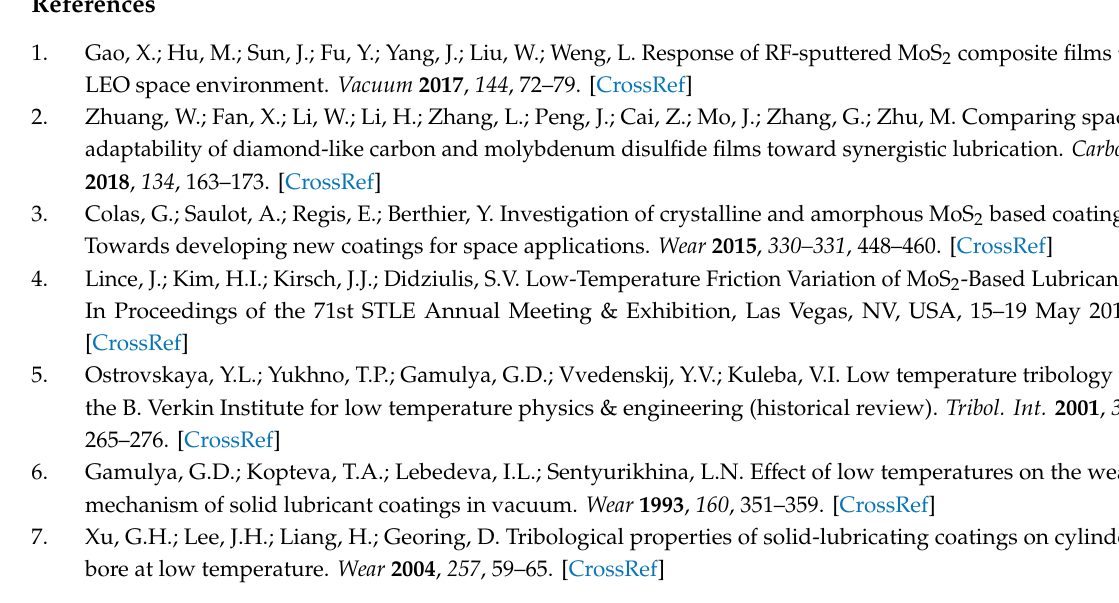
Figure S1: Possible local structures / atomic packings in amorphous MoS x coatings with x~2, 3, and 4 (Mo atoms—blue, S atoms—yellow). Di ff erent types of S ligands that may present in polymerized amorphous MoS x structures are indicated for Mo 3 S 12 and Mo 3 S 13 cluster unites in colored squares: green, terminal S2 2 − ; red, apical S 2 − ; blue, bridging S2 2 − ; yellow, unsaturated S 2 − , Figure S2: Anton Paar TRB3 tribometer modified by the authors for friction testing of MoS x thin-film coatings at low temperatures, Figure S3: Chemical mapping of S, Mo, Fe, and Cr over the surface of di ff erent samples obtained by RPLD of MoS x coatings on the polished steel substrates, Figure S4: RBS spectra for thin MoS x films obtained by RPLD on Si substrates at di ff erent pressures of H 2 S gas, Figure S5: Time-of-flight (TOF) signals of ion pulses detected by an ion probe during the pulsed laser ablation of a Mo target at di ff erent pressures of H 2 S gas, Figure S6: High resolution TEM and SAED patterns for thin MoS 4 film obtained by RPLD. The time of in situ electron beam irradiation of the film in the microscope was (a) 2 and (b) 10 min. The e-beam irradiation caused the local modification / crystallization of the film. Lattice spacing in the e-beam induced nanophase was ~0.26 nm. The nature of this nanophase has not been established. It can be assumed that the electron irradiation caused the desorption of sulfur atoms and, as a result, the local formation of the Mo 2 S 3 nanocrystals in the amorphous MoS x matrix. The high resolution TEM image of this compound clearly showed the lattice spacing of 0.255 nm [1], Figure S7: 2D images and profiles of the wear scar edge for the di ff erent MoS x coatings measured after tribo-testing at − 100 ◦ C in an oxidizing environment. Red lines show the cross sections of wear scars at indicated places; blue lines show the depths of the tracks alone the direction of ball sliding. For the MoS 2 coating, the profilometry studies revealed the uneven wear along the entire track, therefore, su ffi ciently accurate profiling along the track could not be done, Figure S8: Distribution of elements (Mo, S, Fe, Cr, and O) across the central part of the wear track on the MoS 2 coating after tribo-testing at − 100 ◦ C in an oxidizing environment, Figure S9: Distribution of elements (Mo, S, Fe, Cr, and O) across the central part of the wear track on the MoS 3 coating after tribo-testing at − 100 ◦ C in an oxidizing environment, Figure S10: Distribution of elements (Mo, S, Fe, Cr, and O) across the central part of the wear track on the MoS 4 coating after tribo-testing at − 100 ◦ C in an oxidizing environment, Figure S11: Friction curves of tests conducted at 22 ◦ C for di ff erent RPLD MoS x coatings in an argon-air mixture (RH~9%), Figure S12: Optical images of the wear tracks for di ff erent MoS x coatings after tribo-testing at 22 ◦ C in an argon-air mixture (RH~9%), Figure S13: Friction curves of tests conducted at 22 ◦ C for di ff erent RPLD MoS x coatings in air (RH~50%), Figure S14: Optical images of the wear tracks for di ff erent MoS x coatings after tribo-testing at 22 ◦ C in air